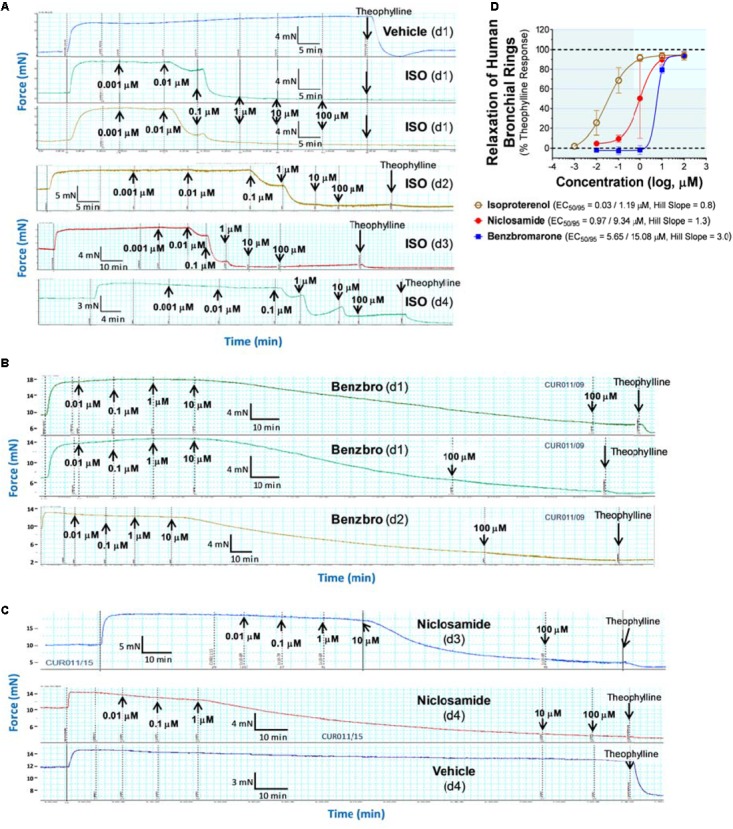
The hydrophilic β-agonist, isoproterenol, acts quickly to relax human bronchial rings while the lipophilic TMEM16A antagonists, benzbromarone and niclosamide, have a slow onset of action. Raw wire myograph recordings of force changes over time are shown for isoproterenol (A), benzbromarone (B), and niclosamide (C) relaxation of human bronchial rings pre-contracted with histamine and the average concentration-response relationship (D). Force changes after histamine addition are stable over time and unaffected by repeat additions of Vehicle control (A - top panel and C - bottom panel; vertical black dotted lines). Isoproterenol (ISO) is hydrophilic (XLogP3 = –3.49) and has a quick onset of action, taking less than ∼ 7 min at 10 or 100 nM concentrations to achieve steady-state relaxation of the human bronchial rings (A), with results from four donors (d1–d4) being shown. In contrast, the lipophilic TMEM16A antagonist benzbromarone (Benzbro) (XLogP3 = 5.66) has a slow onset of action (B) in relaxing bronchial rings from donors d1 and d2, taking 80–140 min at 10 μM before force changes have reached a plateau. Niclosamide which is also lipophilic, XLogP3 = 5.32, similarly acted slowly taking ∼50 min at 10 μM and ∼92 min at 1 μM to achieve steady-state relaxation of the bronchial tissue from donors d3 and d4 (C). To confirm responsiveness of each donor, isoproterenol is routinely run as a positive control. Mean ± SEM, N = 2–5.